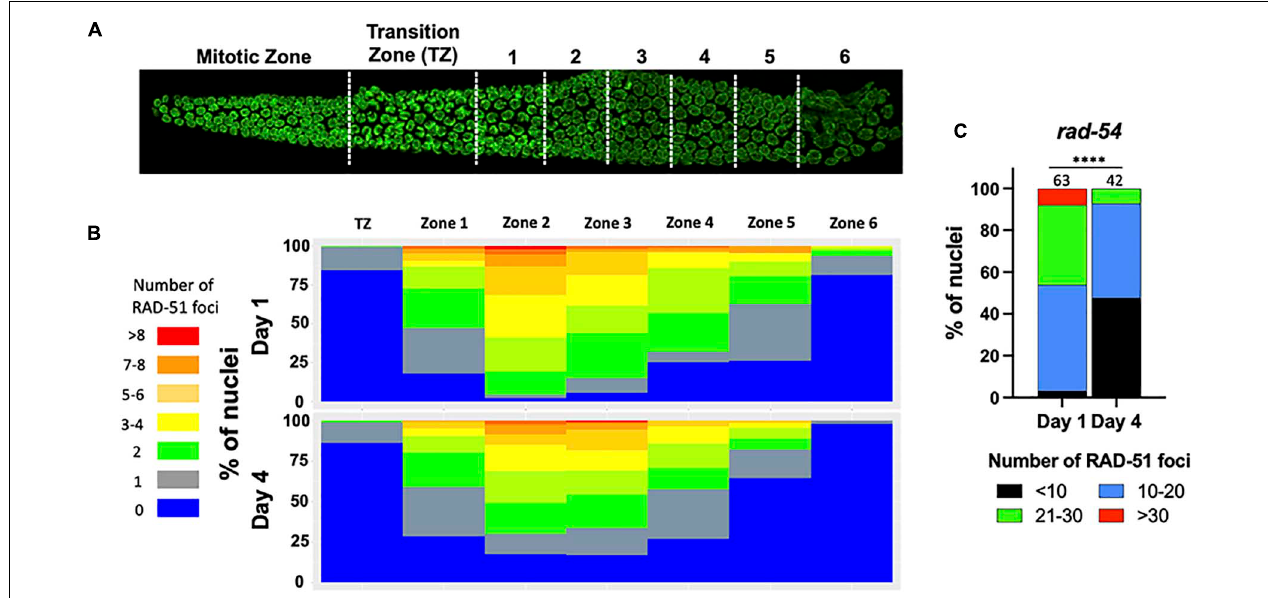
FIGURE 2 | Fewer RAD-51 foci in meiotic nuclei from aged mothers. (A) DAPI-stained C. elegans germ line showing the regions in which RAD-51 foci were quantified. Each zone corresponds to a particular meiotic stage: Transition zone (TZ) corresponds to leptotene and zygotene, Zones 1 and 2 to early pachytene, Zones 4 and 5 to middle pachytene and Zones 5 and 6 to late pachytene. (B) The percentage of nuclei in each zone containing the indicated number of RAD-51 foci. Four gonads per age in N2 worms were quantified. (C) Quantification of RAD-51 foci in the rad-54(ok615) mutant background. Shown is the percentage of nuclei in late pachytene nuclei containing the indicated number of RAD-51 foci. Numbers on top of bars indicate the total number of nuclei analyzed per age. Statistical significance was determined using Chi-square test. ∗∗∗∗ p <